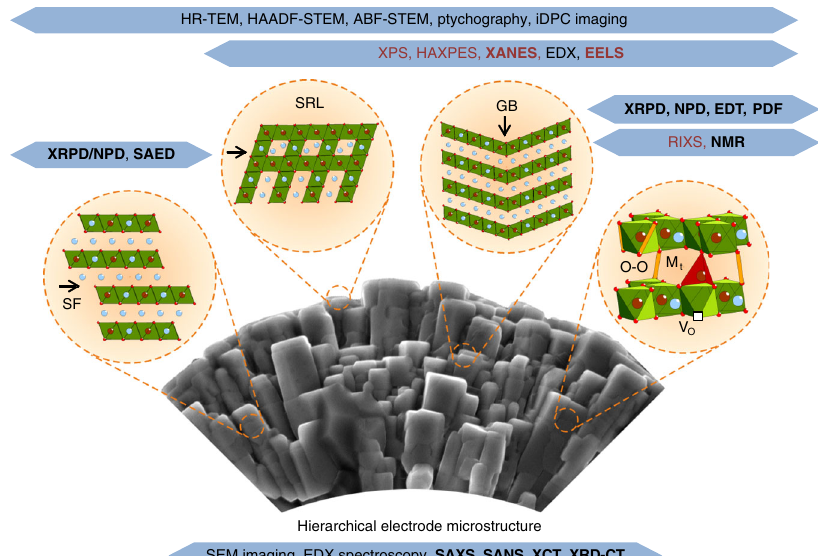
Fig. 4 Digging into the crystal structure and microstructure of battery electrodes. Progress in solid state electrochemistry have greatly bene fi t from establishing robust structural-electronic-electrochemical relationships via the proli fi c improvement of available diffraction, imaging and spectroscopic characterization techniques and enabling many of them to act in an operando/in situ mode. They target various local structural aspects (vacancies, defects, stacking faults, structure distortions) as well as chemical and electronic aspects. This fi gure should serve as a guide to the reader for selecting the most suitable type of measurements dealing with a speci fi c problem regarding crystal structure, chemical bonding, electronic structure and composition (as exempli fi ed with the layered rock-salt type oxides). The legend: SF stacking faults; SRL surface reconstruction layer; GB grain boundaries; HR-TEM: high resolution transmission electron microscopy; HAADF-STEM high angle annular dark fi eld scanning transmission electron microscopy; ABF-STEM annular bright fi eld scanning transmission electron microscopy; iDPC integrated differential phase contrast; XPS X-ray photoelectron spectroscopy; HAXPES hard X-ray photoelectron spectroscopy; XANES X-ray absorption near edge structure; EELS electron energy loss spectroscopy; XRPD X-ray powder diffraction; NPD neutron powder diffraction; EDT electron diffraction tomography; SAED selected area electron diffraction; PDF pair distribution function analysis; RIXS computed tomography; XRD-CT X-ray diffraction computed tomography. The techniques to probe atomic arrangement are shown in black, those